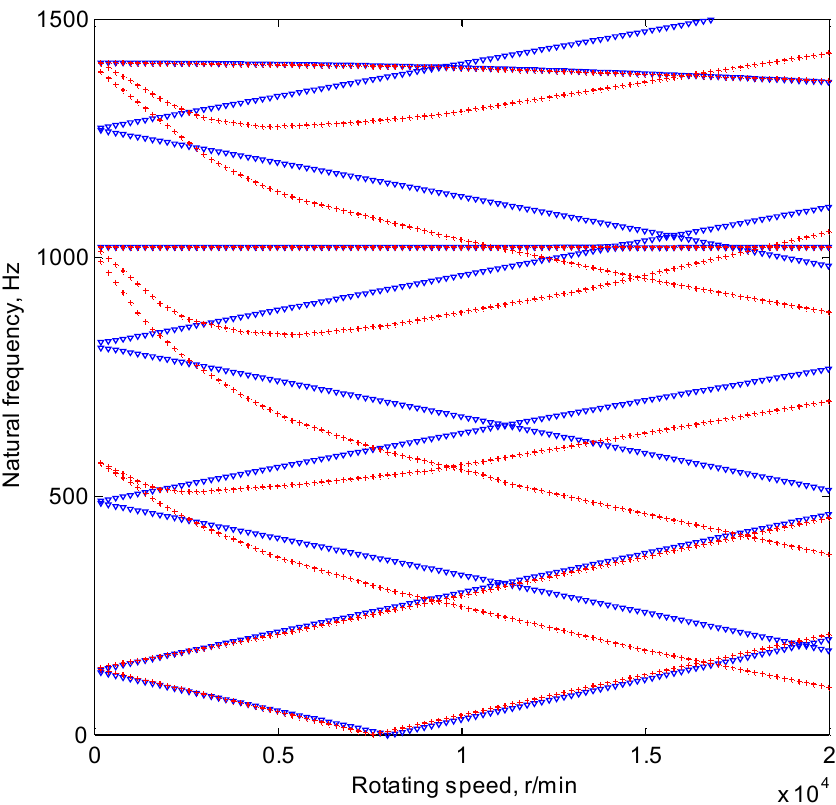
α = ; ( b ) 0.6 α = ; ( c ) 0.7 α = ; ( d ) k k k